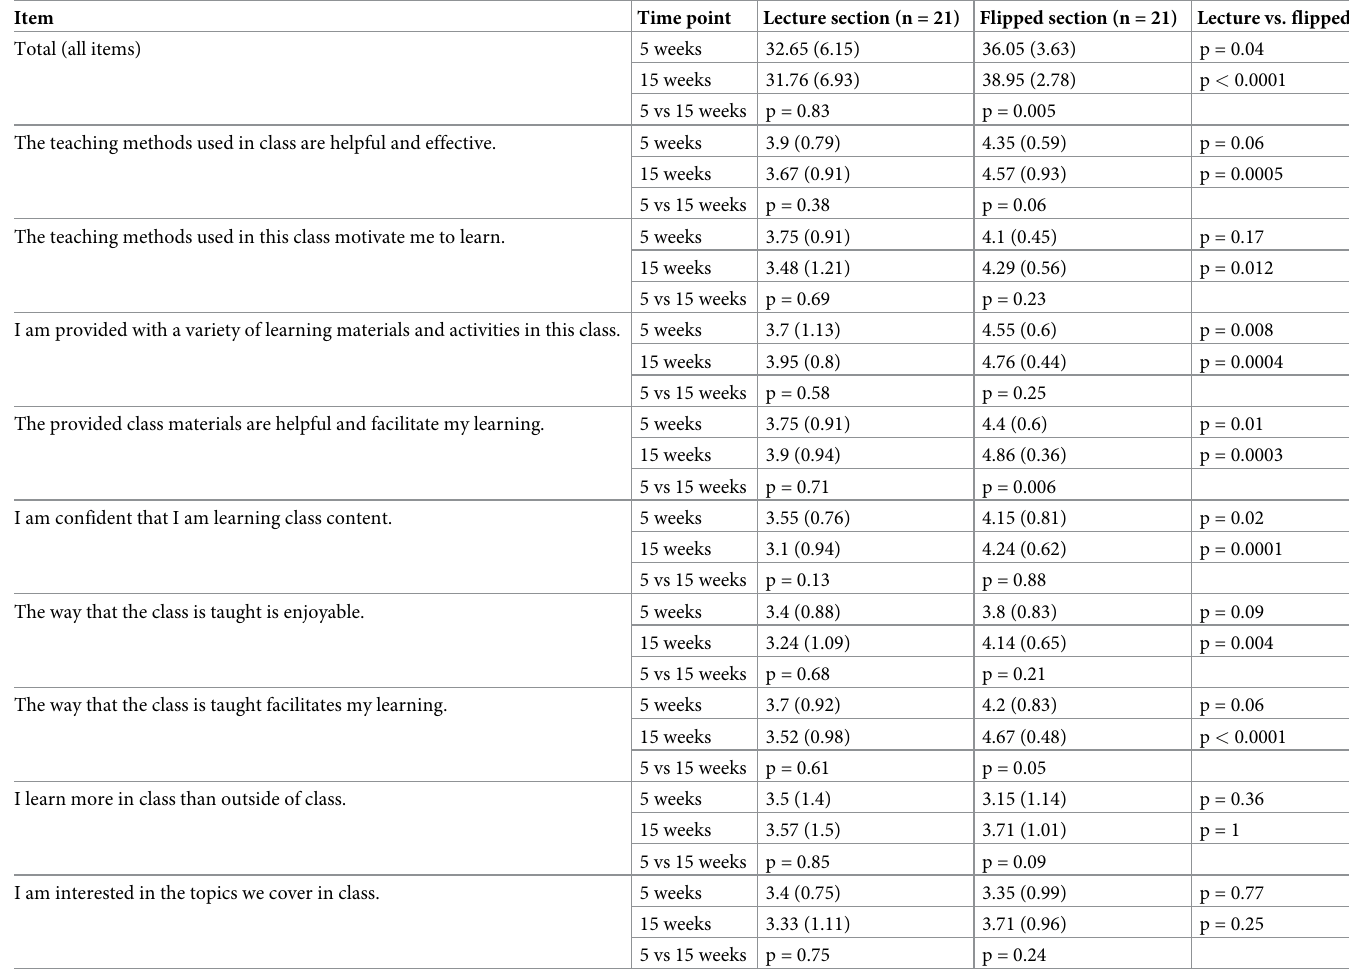
Table 4. Student satisfaction survey